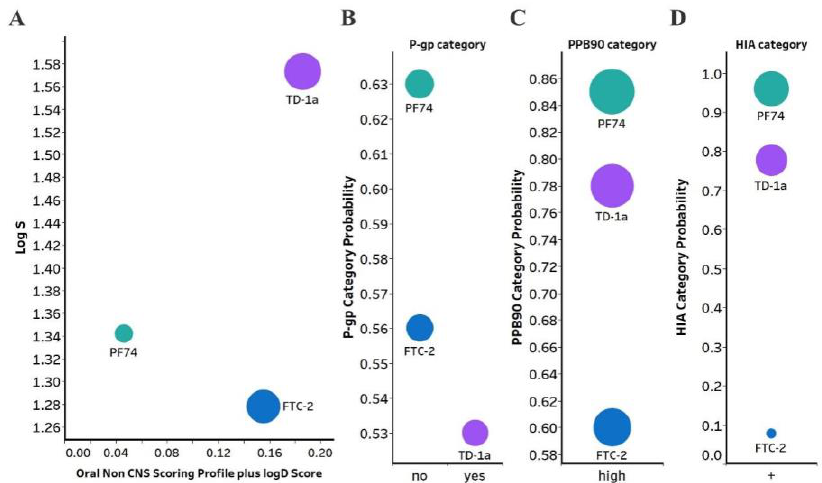
Figure 5. ( A ) Plot showing the StarDrop (Optibrium, Ltd., Cambridge, UK)–derived logS versus a multimetric oral non-CNS profile score. Importance for the score: logS = 0.9, HIA = 0.85, logP = 0.6, logD = 0.6, hERG pIC50 = 0.4, 2D6 affinity category = 0.3, 2C9 pKi = 0.3, P-gp category = 0.3, PPB90 category = 0.2, BBB category = 0.11, BBB log(brain:blood) = 0.11 ( B ) P-gp category, ( C ) PPB90, Plasma protein binding >90%, ( D ) HIA, human intestinal absorption category, and probability of prediction of FTC-2, TD-1a and PF-74 . The size of the circles correlates with the corresponding score or probability.